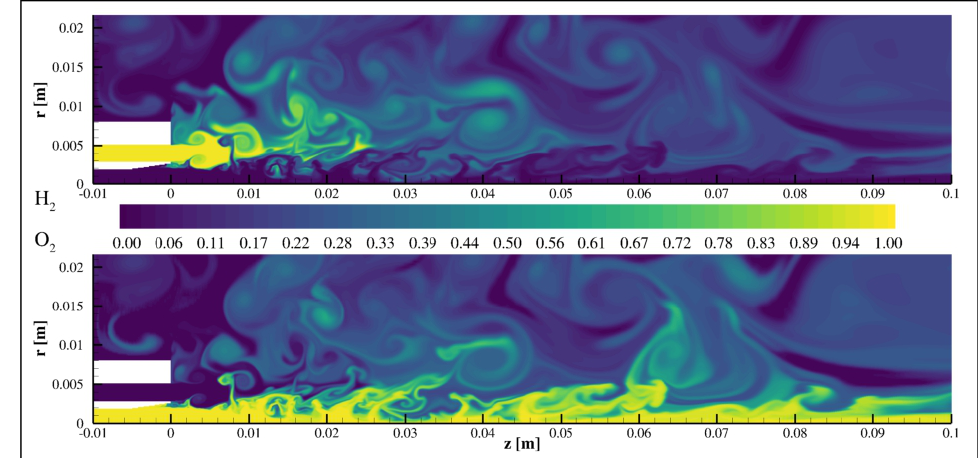
Figure 18. Numerical instantaneous distribution of hydrogen and oxygen mass fractions for the investigated flow without ignition of reactants, i.e., with a non-reacting shear-layer between the liquid O 2 and the gaseous H 2